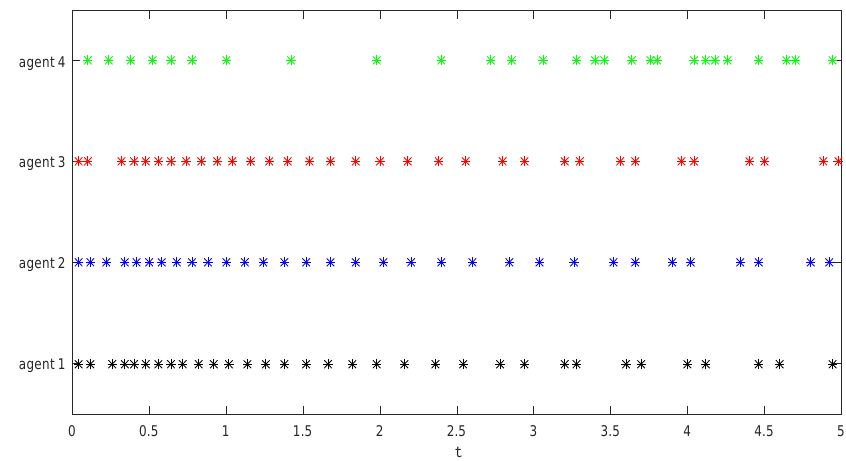
Figure 4. The controller update time instants of each agent with algorithm